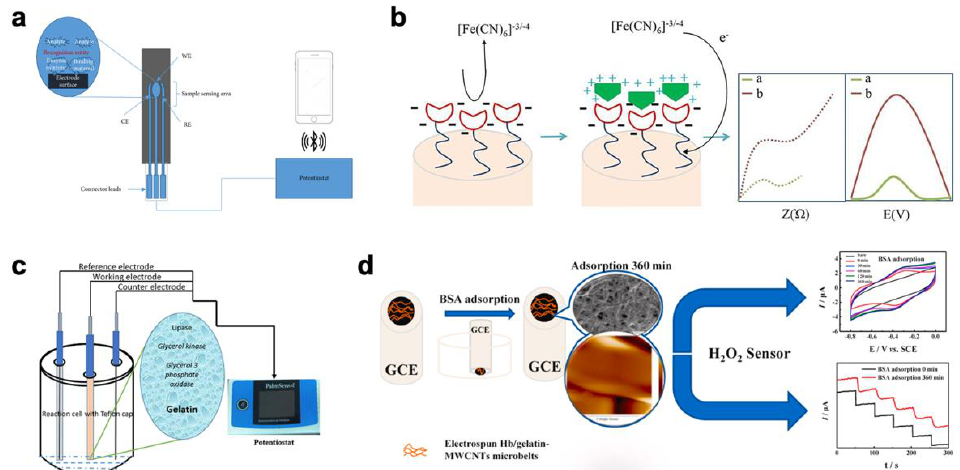
Figure 2. Biosensors for food testing with gelatin matrix. ( a ) Schematic representation of the screen- printed electrode biosensor [44] (copyright (2020) D. Manoj et al.); ( b ) red markings point the steps that pose potential challenge towards ensuring the sensory and nutritional quality of the fruit juice [45] (copyright (2022) Elsevier Ltd.); ( c ) amperometric enzyme-based biosensor to evaluate adulteration in virgin coconut oil [48] (copyright (2022) Wiley Periodicals LLC.); ( d ) scheme of fabrication procedure for electrospun Hb/gelatin-MWCNTs/GC electrode [50] (copyright (2020) Elsevier B.V.).